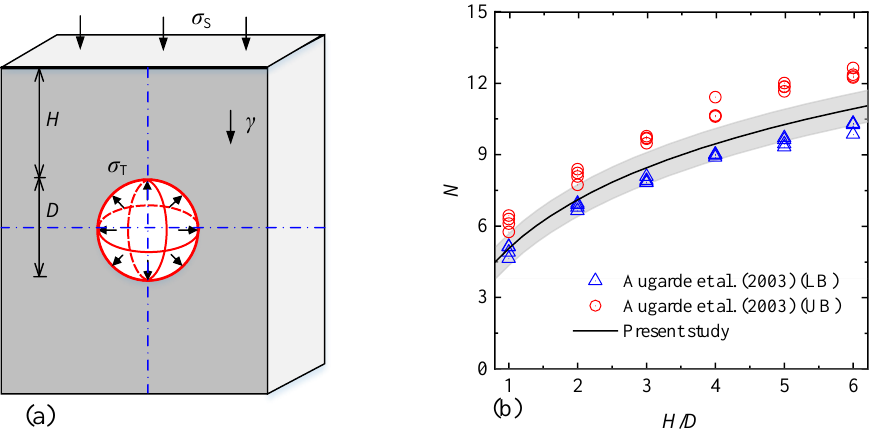
Figure 6. Sinkhole stability: ( a ) calculation model; ( b ) comparison of predicted stability numbers with FELA results.